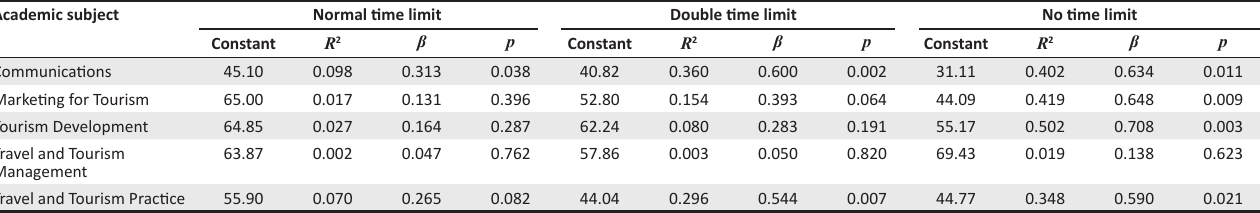
TABLE 4: Regression values for the Vocabulary in Context test on the first-test subject marks by time-limit group. Academic subject Normal time